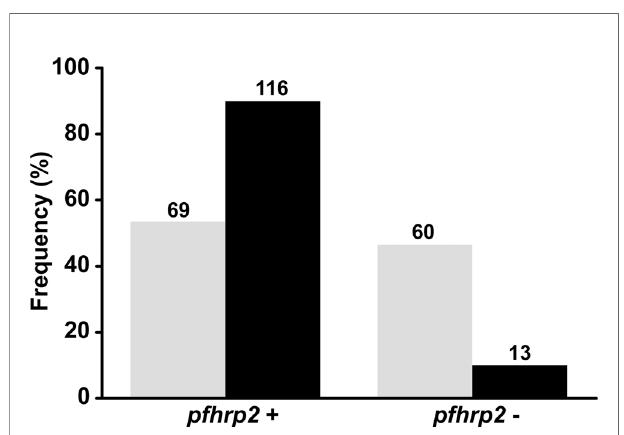
FIGURE 2 | Association between the results of rapid diagnostic tests (RDTs) of malaria and parasitemia for subjects with clinical malaria caused by P. falciparum . Parasitemia (parasites/µL) in 84 samples was estimated based on microscopic analysis. Samples from Rondo ̂ nia and Roraima were screened using an SD Bioline Malaria Ag P.f/Pan test (Abbott) at enrollment; samples of dried blood from Mato Grosso were tested using SD Bioline Malaria Ag P.f (Standard Diagnostics). pfhrp2 -negative samples are shown in solid circle. RDT - and RDT + indicate negative and positive RDT results, respectively.